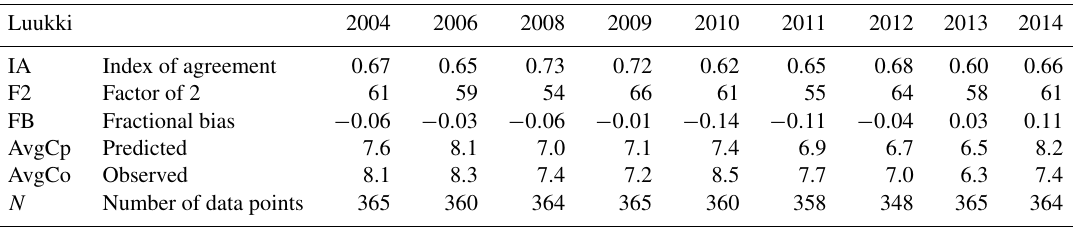
Table 1. Selected statistical parameters associated with the agreement of the measured and predicted daily averaged concentrations of PM 2 . 5 , at the regional background station of Luukki, from 2004 to 2014. The average values of the measurements and predictions and the numbers of data points have also been